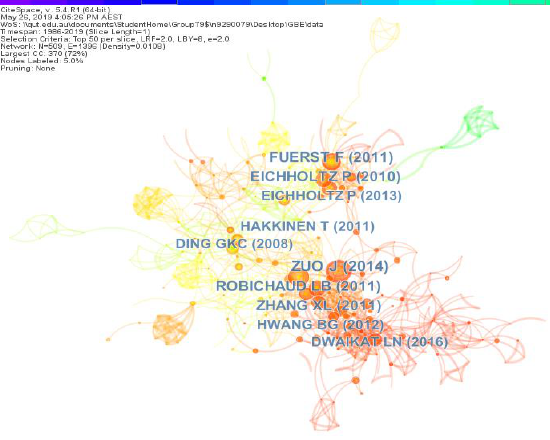
Figure 1. Document co-citation network of GBE.